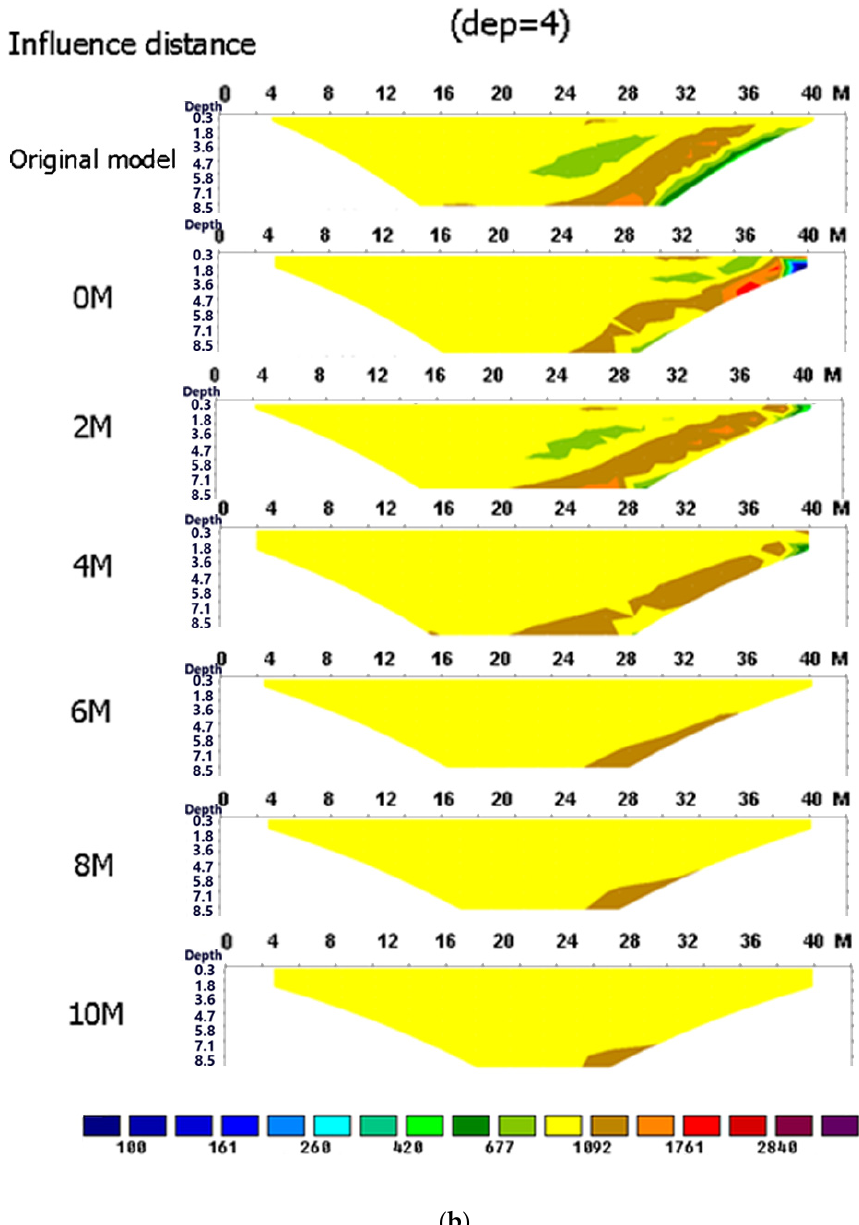
Figure 11. The influence of the boundary effect with different medium depths. ( a ) medium depth 2 m; ( b ) medium depth 4 m.